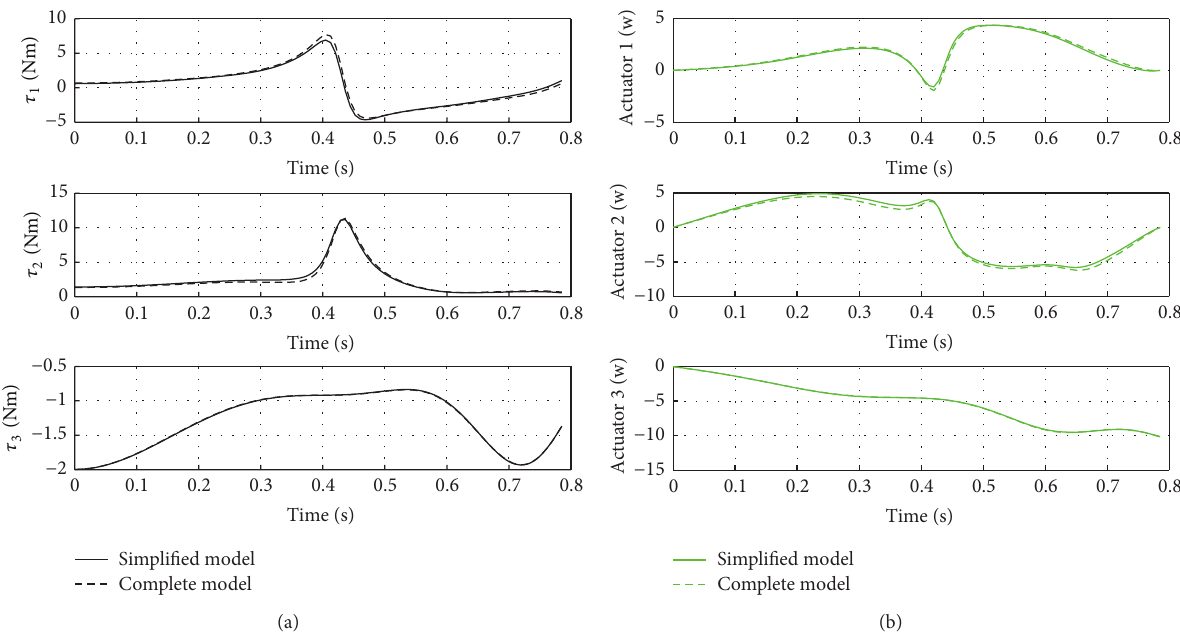
Figure 10: The dynamic simulation results of trajectory 2 with external moment: (a) actuator torque; (b) actuator power.